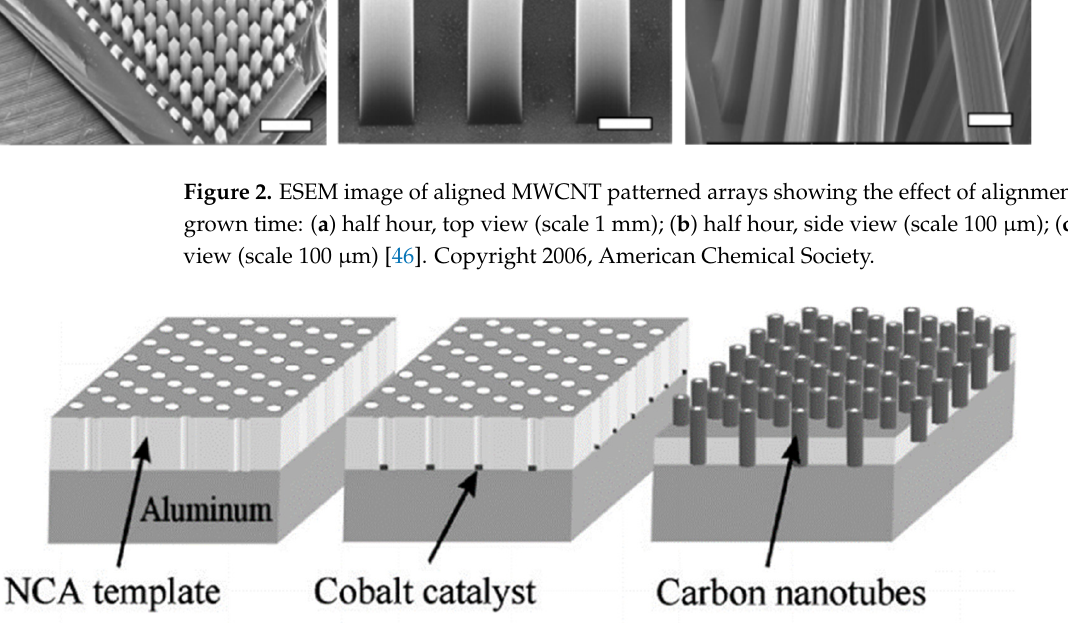
Figure 3. Schematic of fabrication process with a template. Reproduced with permission [49]. Copyright 1999, AIP Publishing.